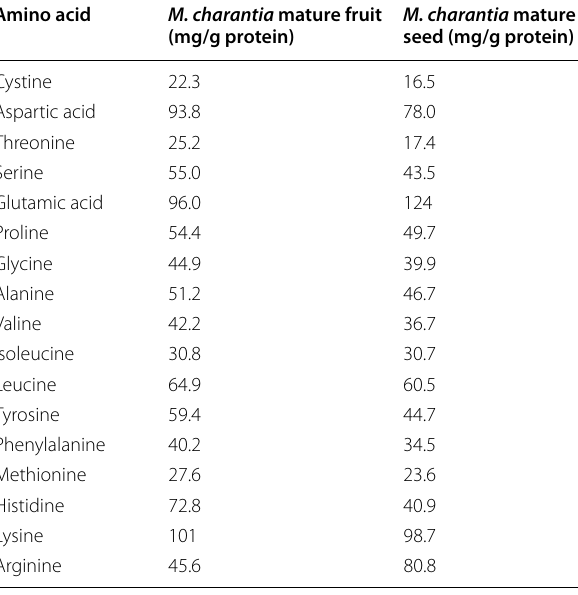
Table 2 Amino acid composition of bitter gourd mature fruit and seed (Adapted from Nagarani et al. 2014; Sorifa